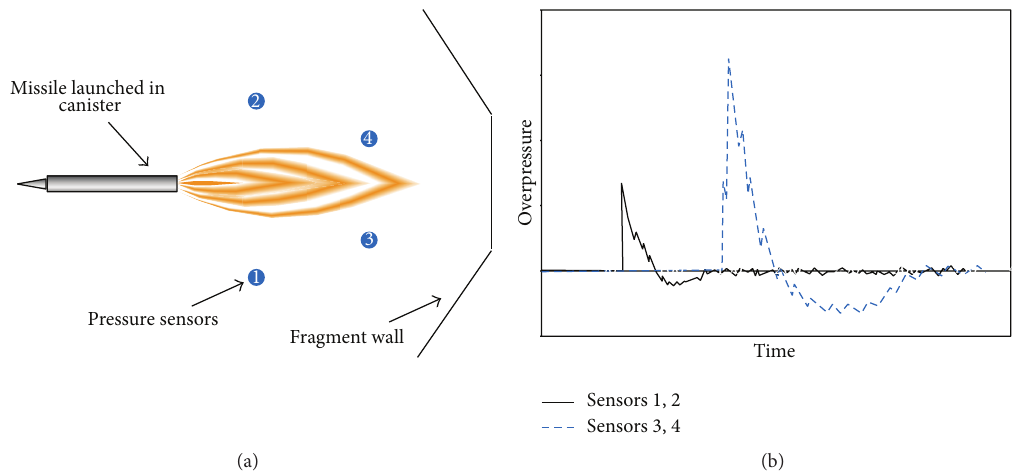
Figure 1: Illustration (top view) of laboratory test launch of missile with highlighted pressure sensors (a) and qualitative illustration of the pressure-time results